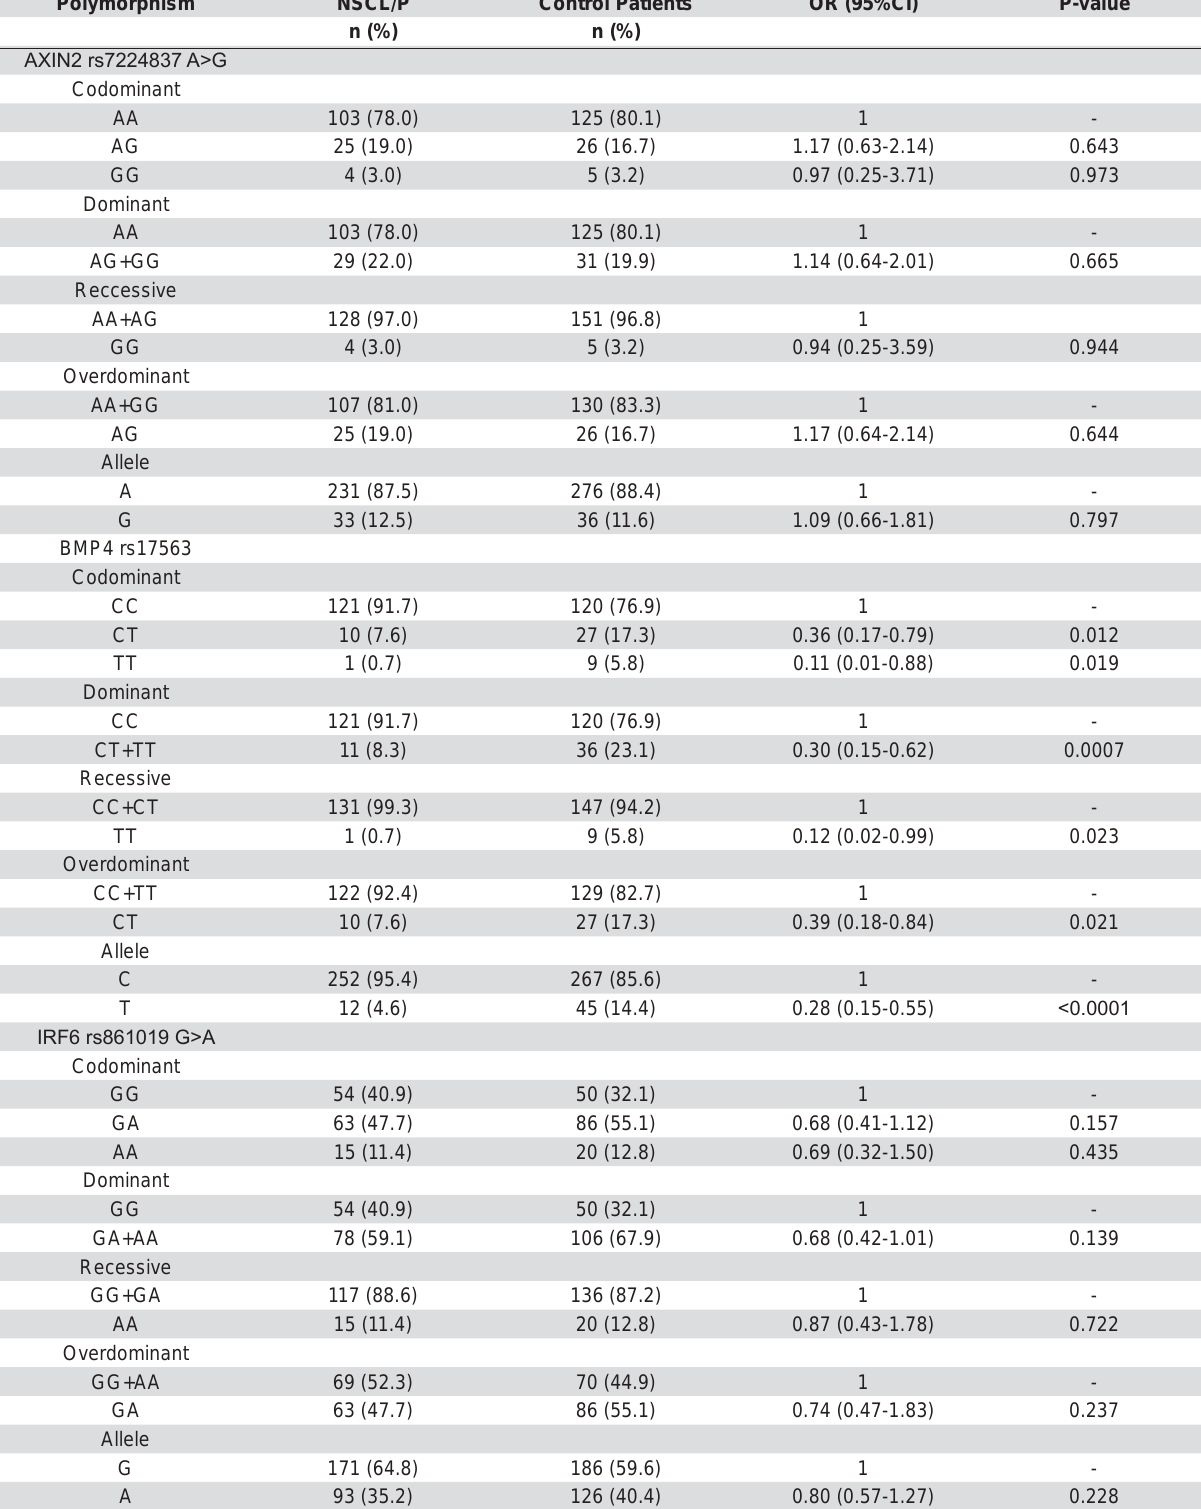
Table 1- Genotype and allele frequencies of AXIN2, BMP4, and IRF6 polymorphisms in CL/P and control